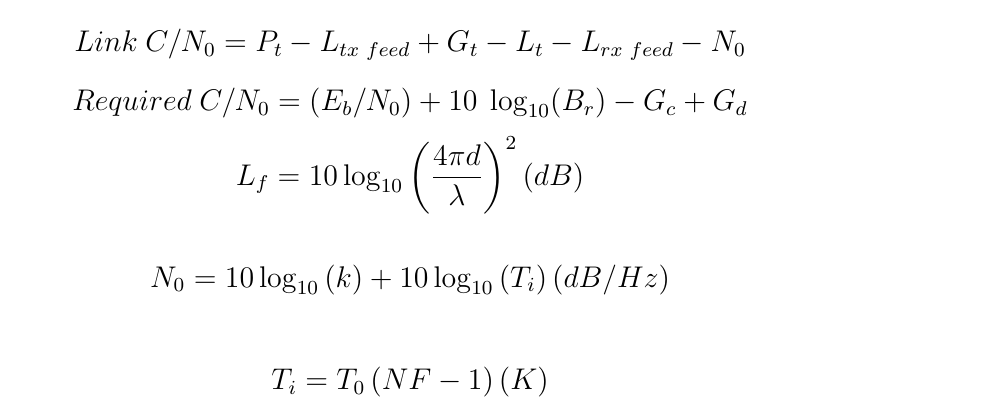
Figure 9. Configuration to calculate the link budget for the in-to-out body